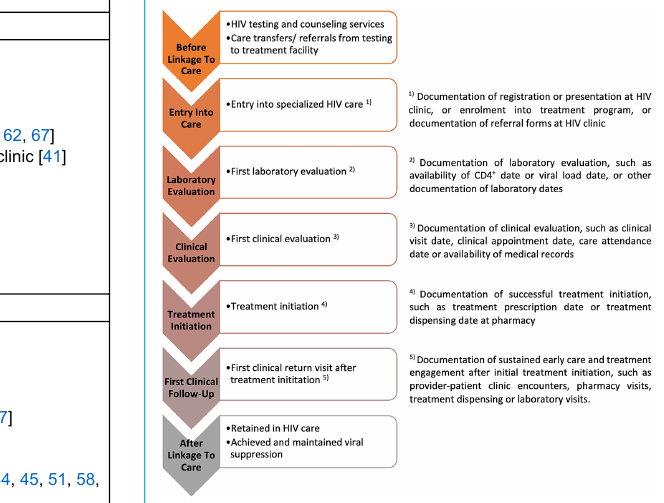
Figure 2: “Linkage to care” framework: patient flow and framework elements based on the Chronic Diseases Clinic of Ifakara and the KIULARCO programme, and numerators of each framework ele- ment to ensure “linkage to care” according to